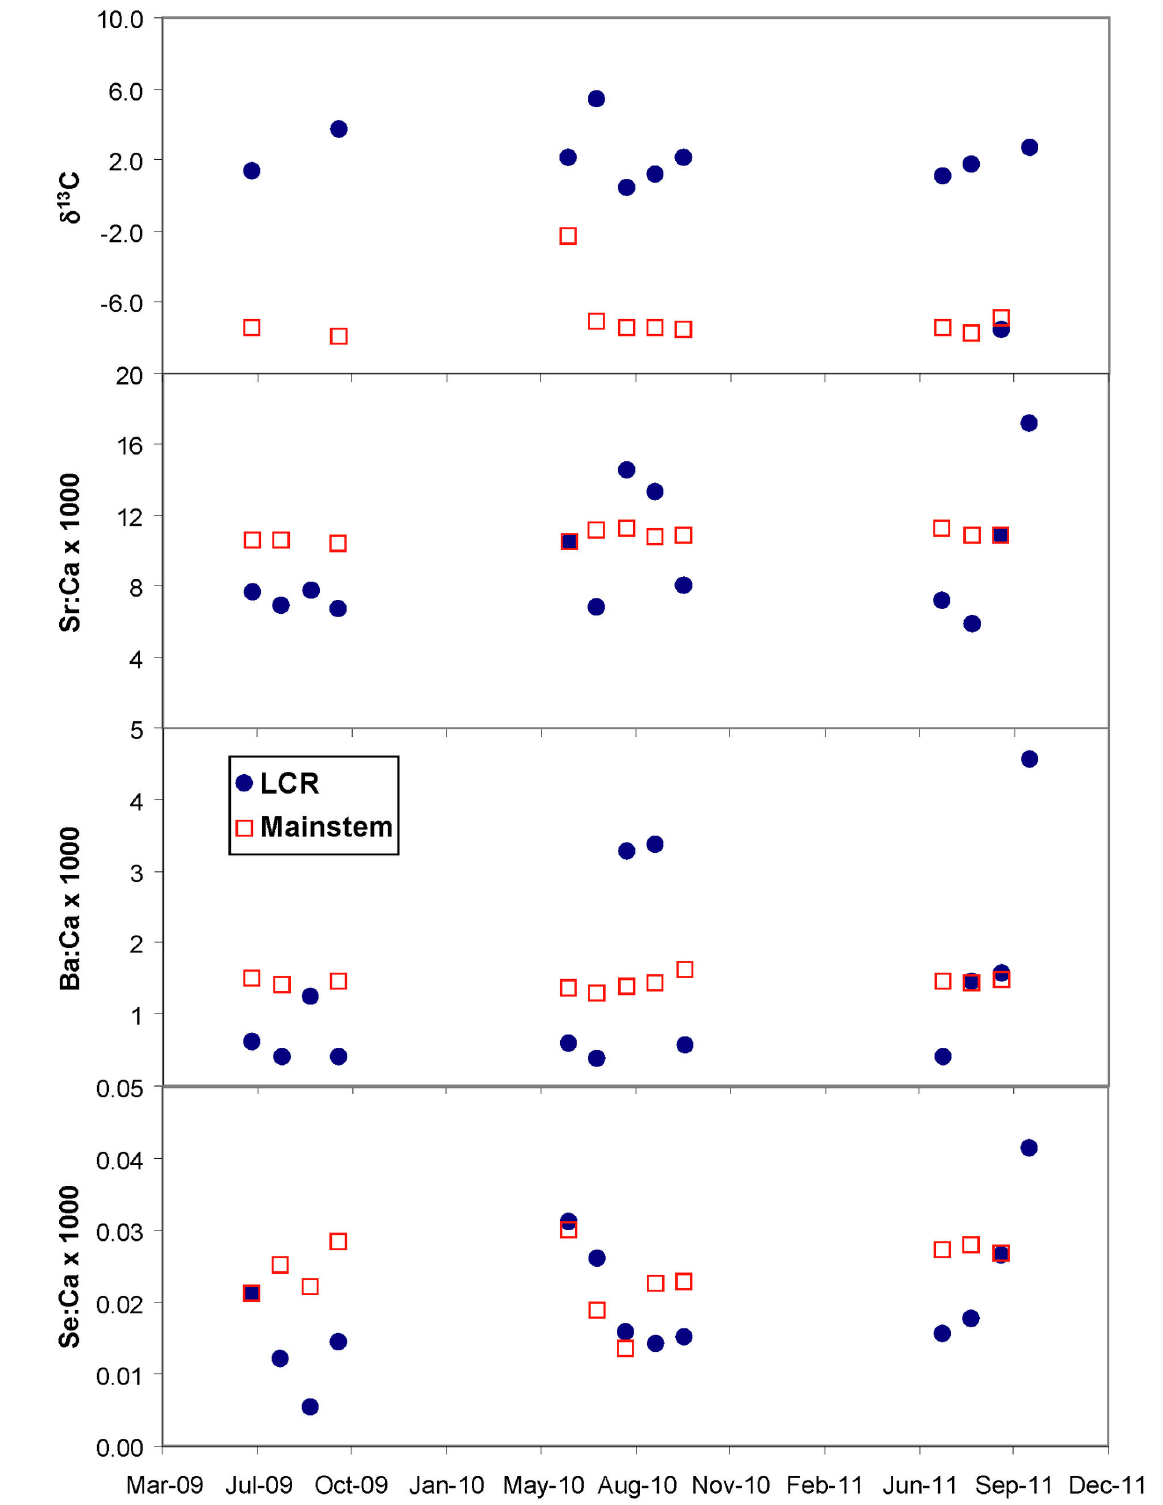
Figure 4. Comparison of water chemistry in the mainstem just above Little Colorado River, and Little Colorado River at Boulders, 2009 - 2011. Each year has a single value for July - October. doi: 10.1371/journal.pone.0084235.g004 PLOS ONE |